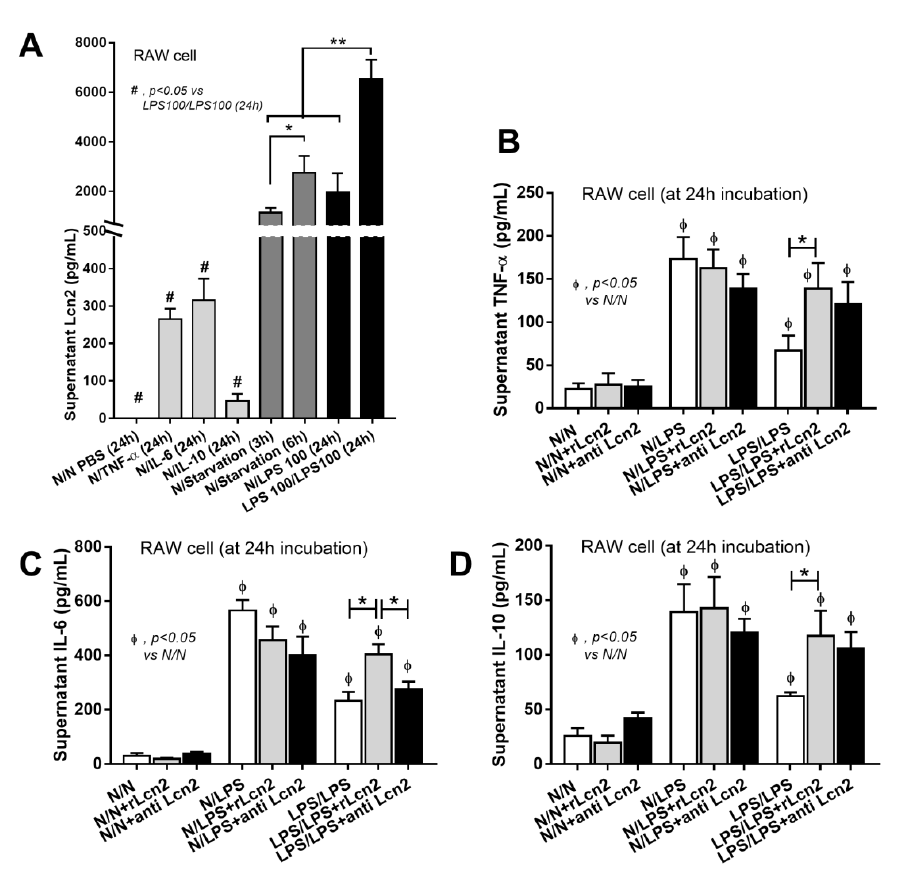
Figure 4. The induction of Lipocalin-2 (Lcn-2) ( A ) in supernatant of RAW264.7 cell with several activators including cytokines (TNF- α , IL-6 and IL-10) ( B – D ) for 24 h, starvation (for 3 h and 6 h), LPS (for 24 h) and LPS tolerance (LPS / LPS at 24 h post-second dose of LPS) (see method) ( A ) were demonstrated. Additionally, the impact of recombinant Lcn-2 (rLcn-2) or LCN-2 blocking antibody (anti-Lcn-2) in RAW264.7 cell after LPS stimulation once (N / LPS) or twice, LPS / LPS versus control (N /